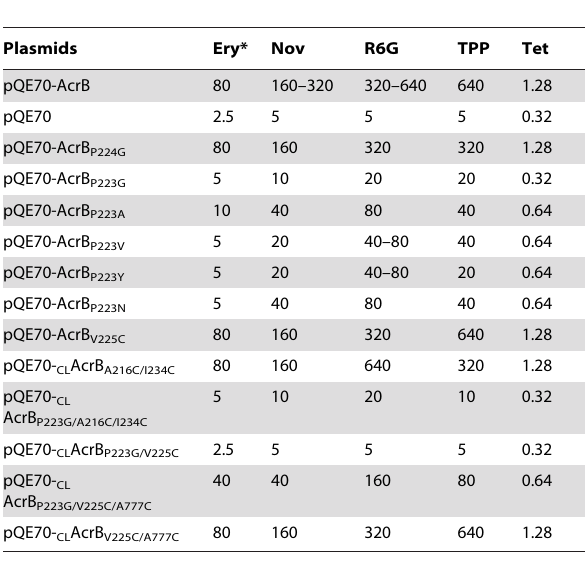
Table 1. MIC ( m g/ml) of BW25113 D acrB containing plasmid encoded AcrB.